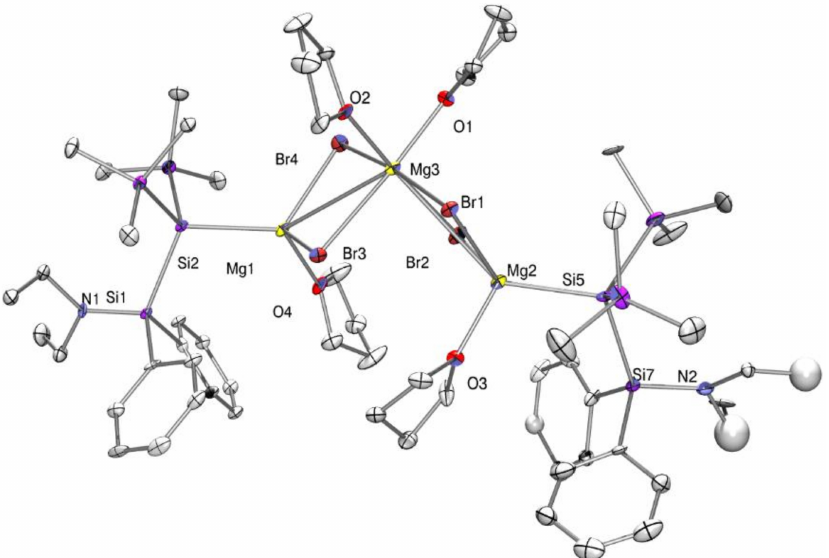
Figure 3. Molecular structure of 1b (thermal ellipsoid plot drawn at the 30% probability level). Only the anionpartofthemoleculeisshown. Allhydrogenatomsareomittedforclarity(bondlengthsinÅ,angles in degrees). The right silanide part of the structure (Si(5)-Si(7) part) is disordered, and therefore no data on this part are listed. Si(1)-Si(2) 2.338(3), Si(2)-Mg(1) 2.601(4), Si(1)-N(1) 1.730(7), Mg(1)-O(4)